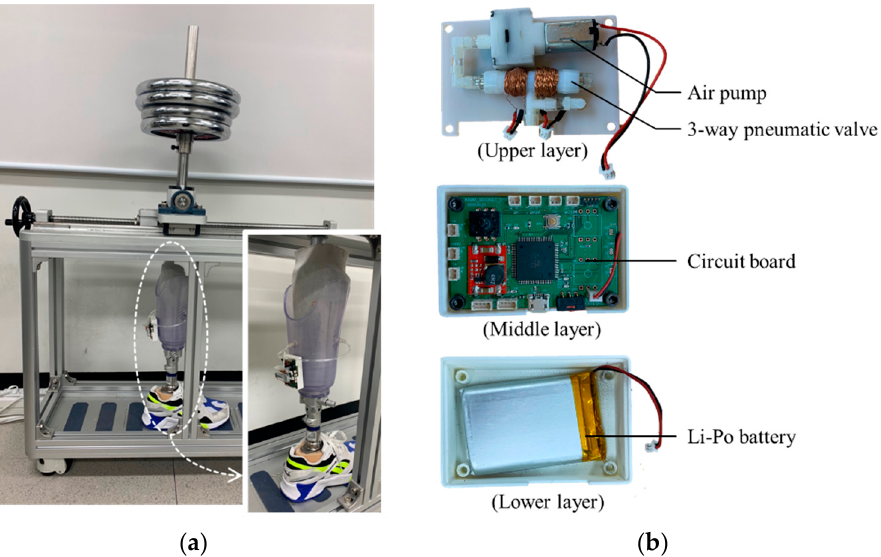
Figure 17. ( a ) The view of the prosthetic socket in the gait simulator; ( b ) the inside view of the portable control device.